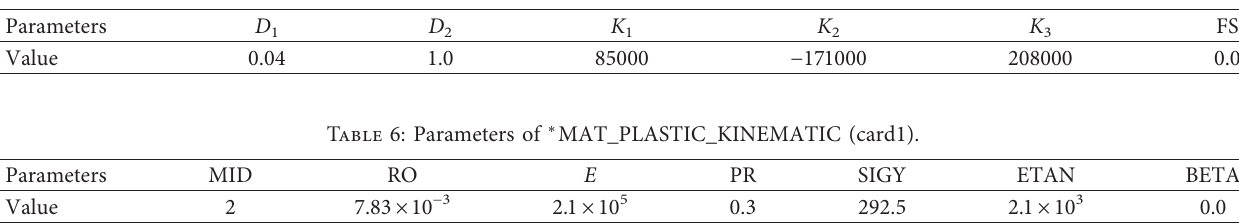
Table 5: Parameters of ∗ MAT_JOHNSON_HOLMGUIST_CONCRETE (card3).